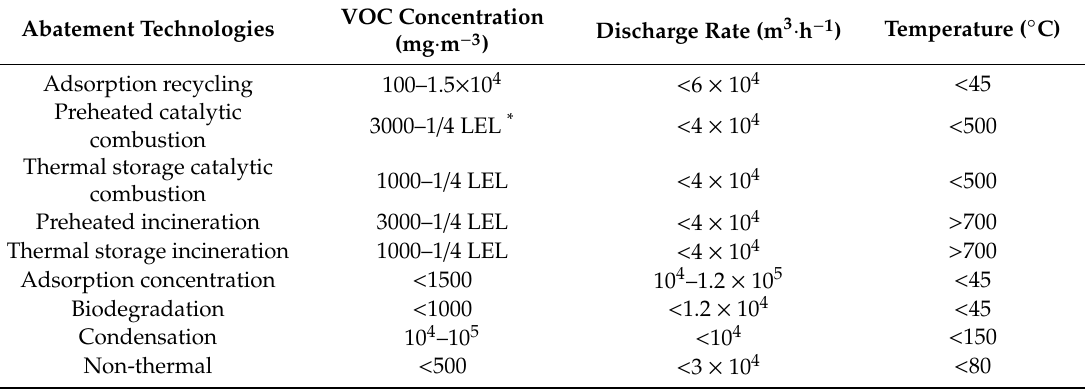
Table 3. VOCs elimination techniques and their operating conditions